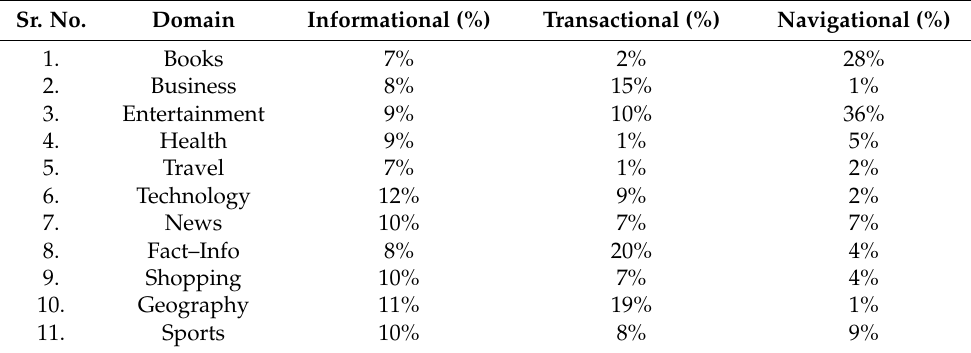
Table 6. Percentage intent distribution with respect to query